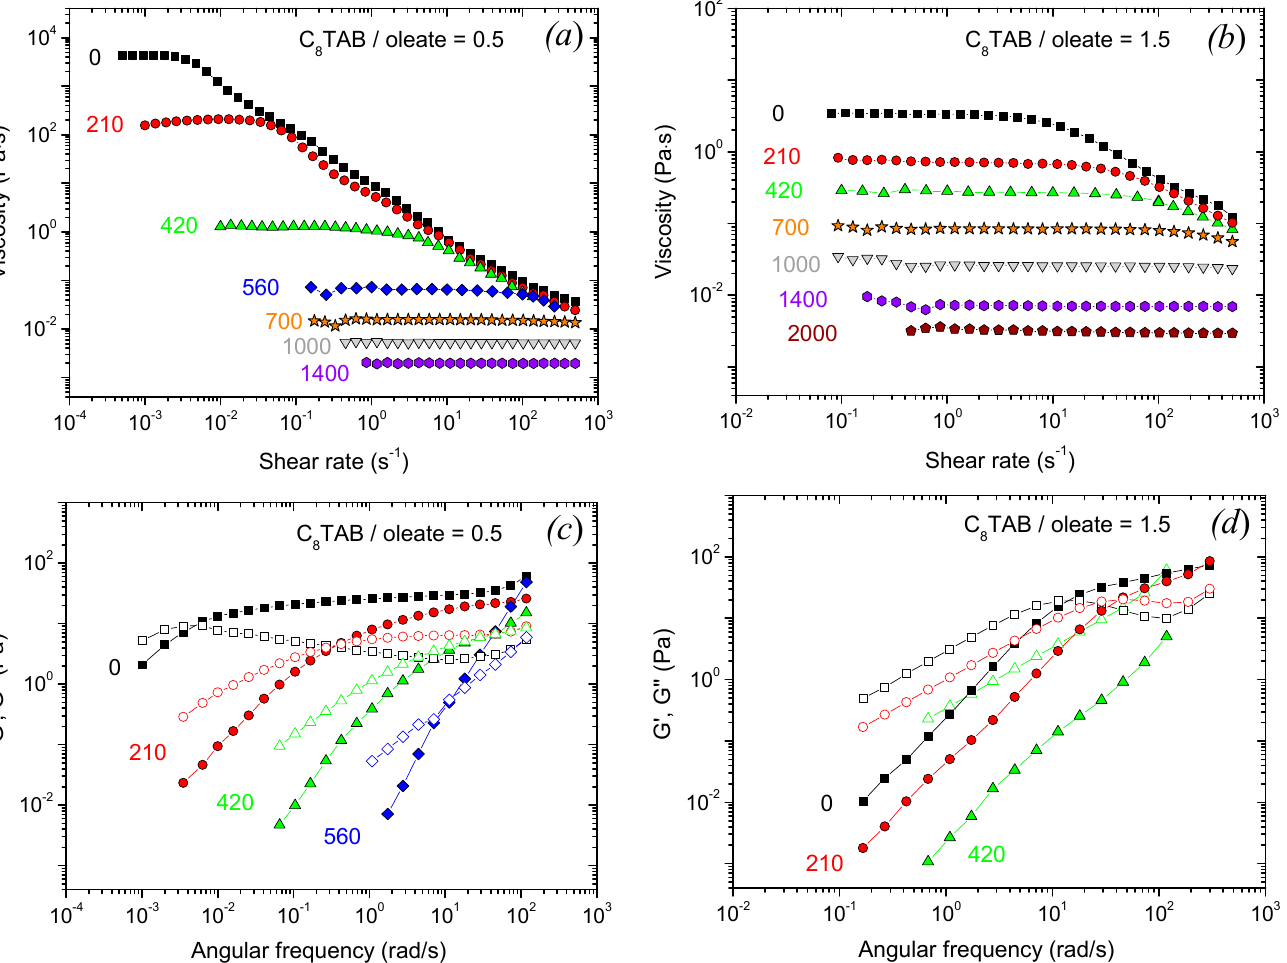
Figure 1. ( a , b ) Flow curves, ( c , d ) frequency dependences of the storage G’ (filled symbols) and loss moduli G” (open symbols) for aqueous solutions containing 78 mM potassium oleate, 39 mM ( a , c ) or 117 mM ( b , d ) C8TAB and different amounts of AA indicated in the Figure in mM. Temperature: 20 °C, pH 11.